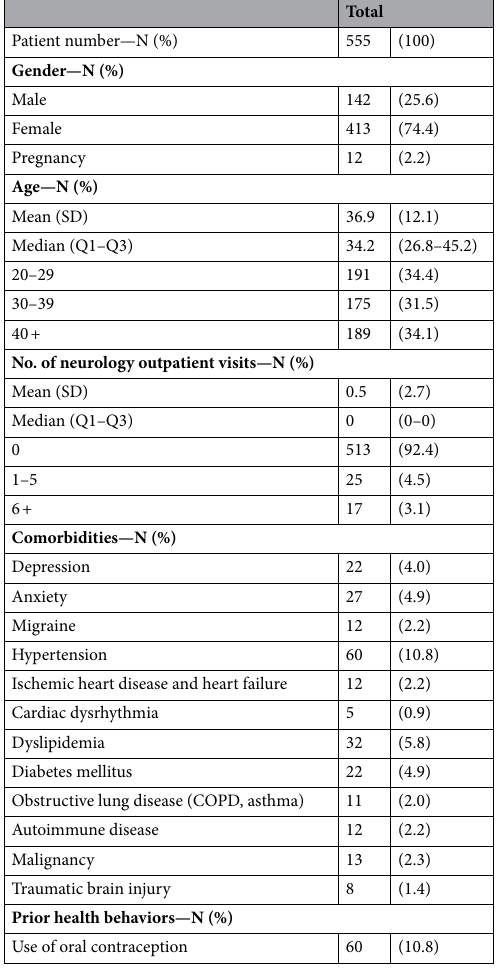
Table 1. Baseline characteristics for incidence cases of multiple